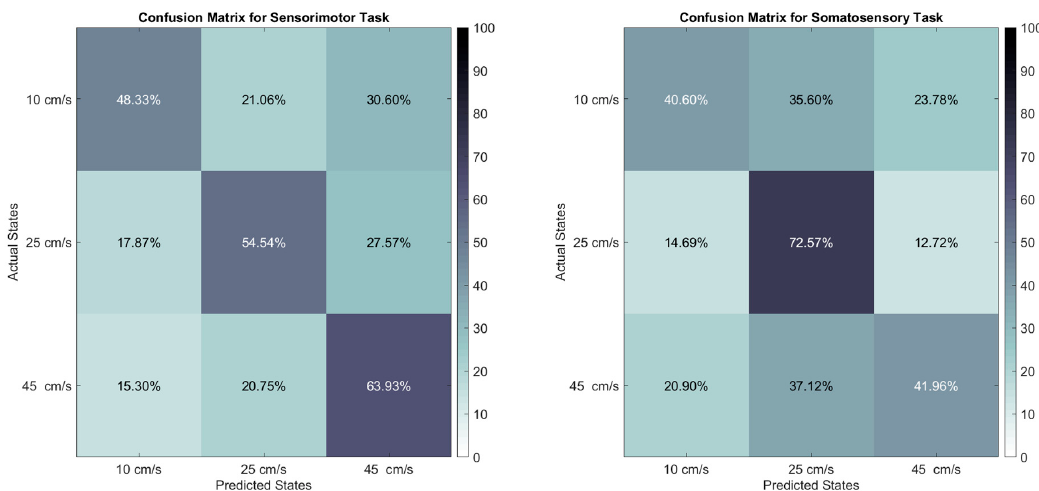
Figure 6. Confusion matrices of the tri-classifiers for the Active (left panel) and Passive (right panel) experiments.